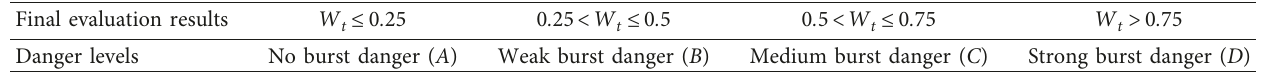
Table 3: The final evaluation results and the corresponding dangerous levels.